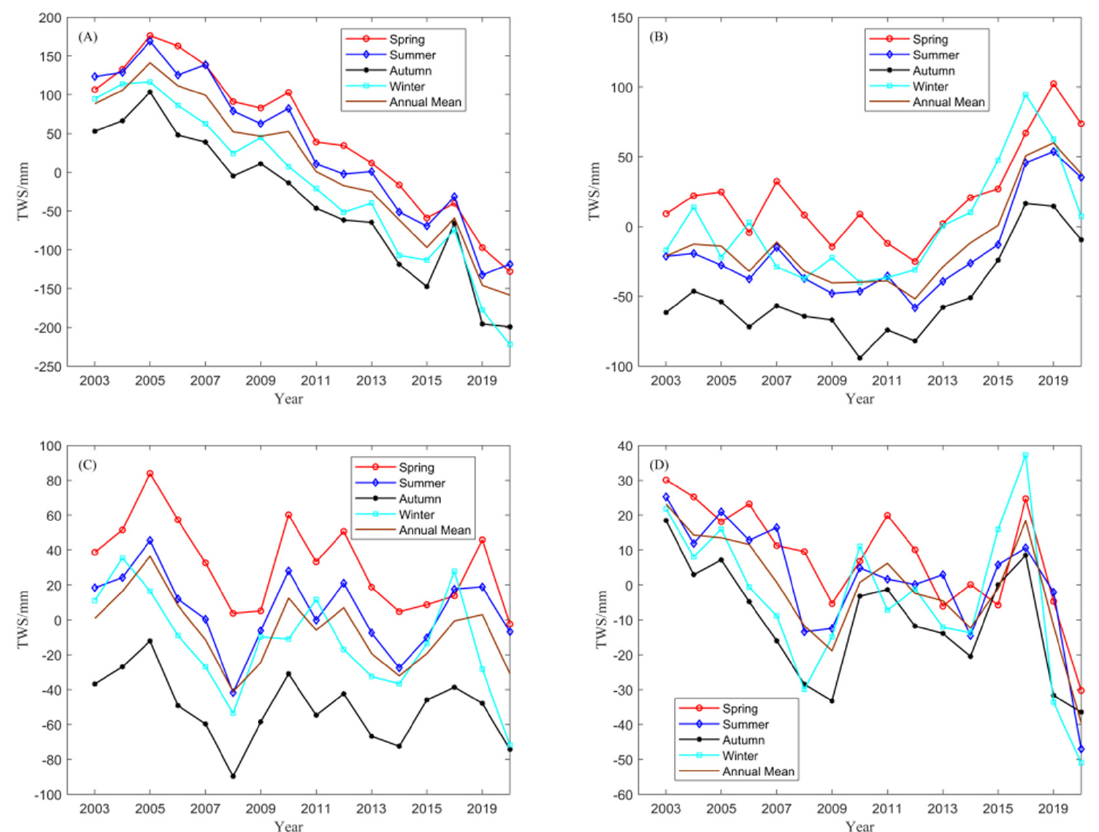
Figure 3. Seasonal variations in the ( A ) Caspian Sea area, ( B ) Kazakhskiy Melkosopochnik, ( C ) Moynkum Desert, and ( D ) Gurbantünggüt Desert TWS values in the arid region of central Asia from 2003 to 2020.